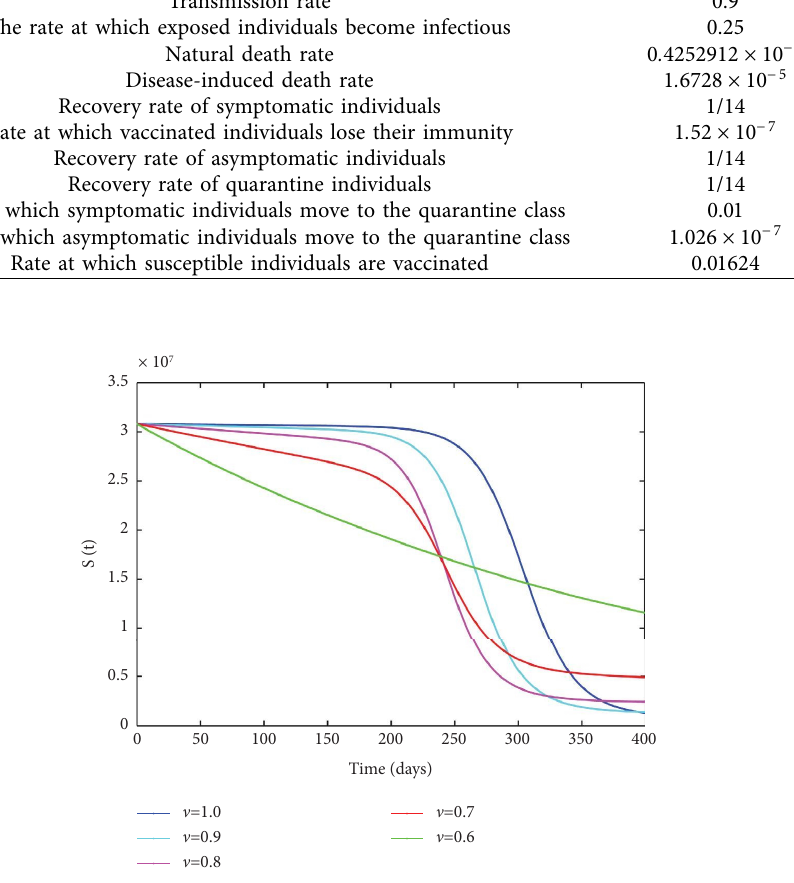
Figure 2: Behaviour of the susceptible individuals at diferent values of v .